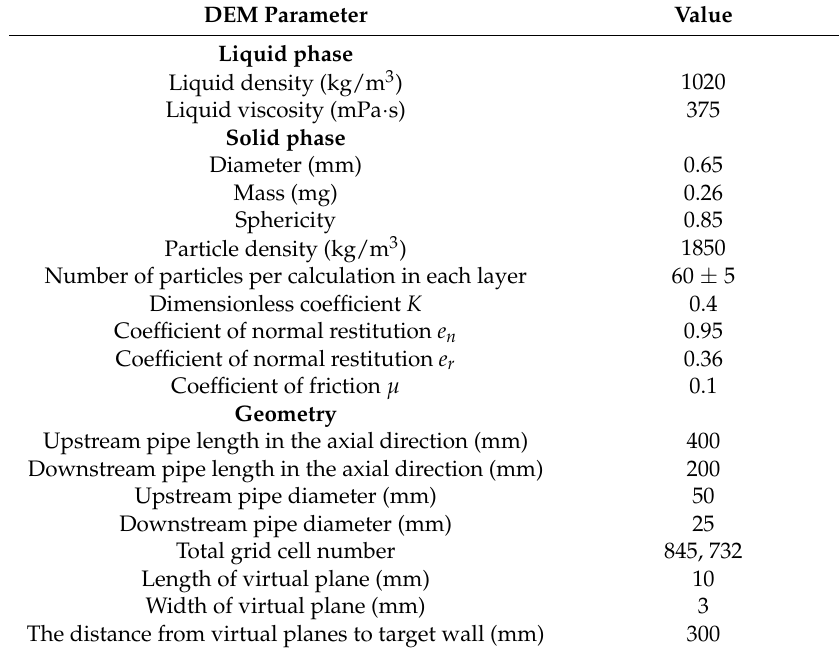
Table 3. CFD-DEM simulation parameters and geometric dimensions of the